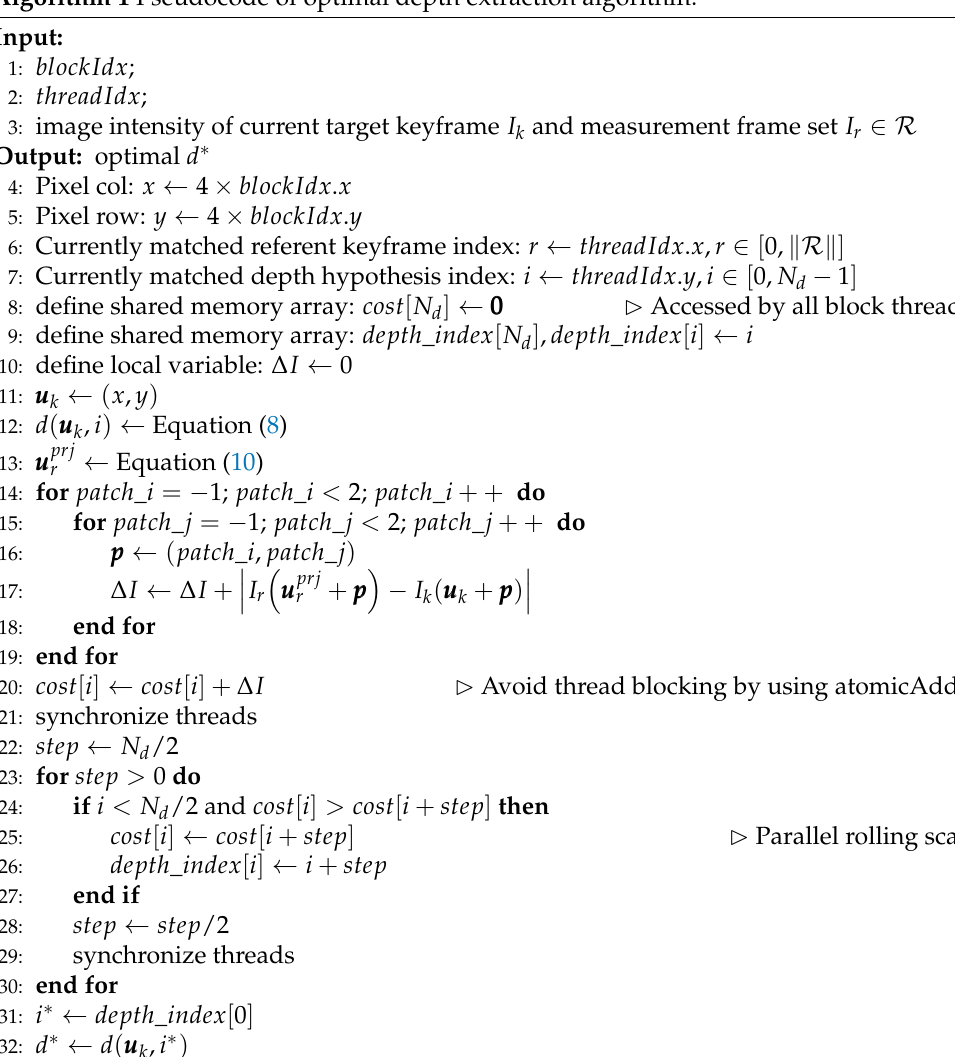
Algorithm 1 Pseudocode of optimal depth extraction